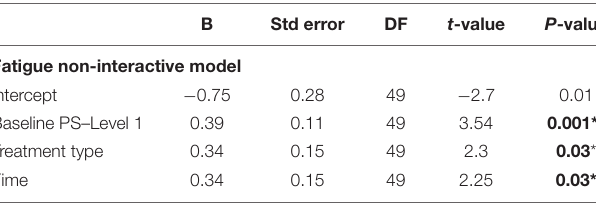
TABLE 4 | A regression model predicting PS scores at post-treatment (t1) and follow-up (t2) on level 8 of the MOXO-CPT, after covarying for PS on level